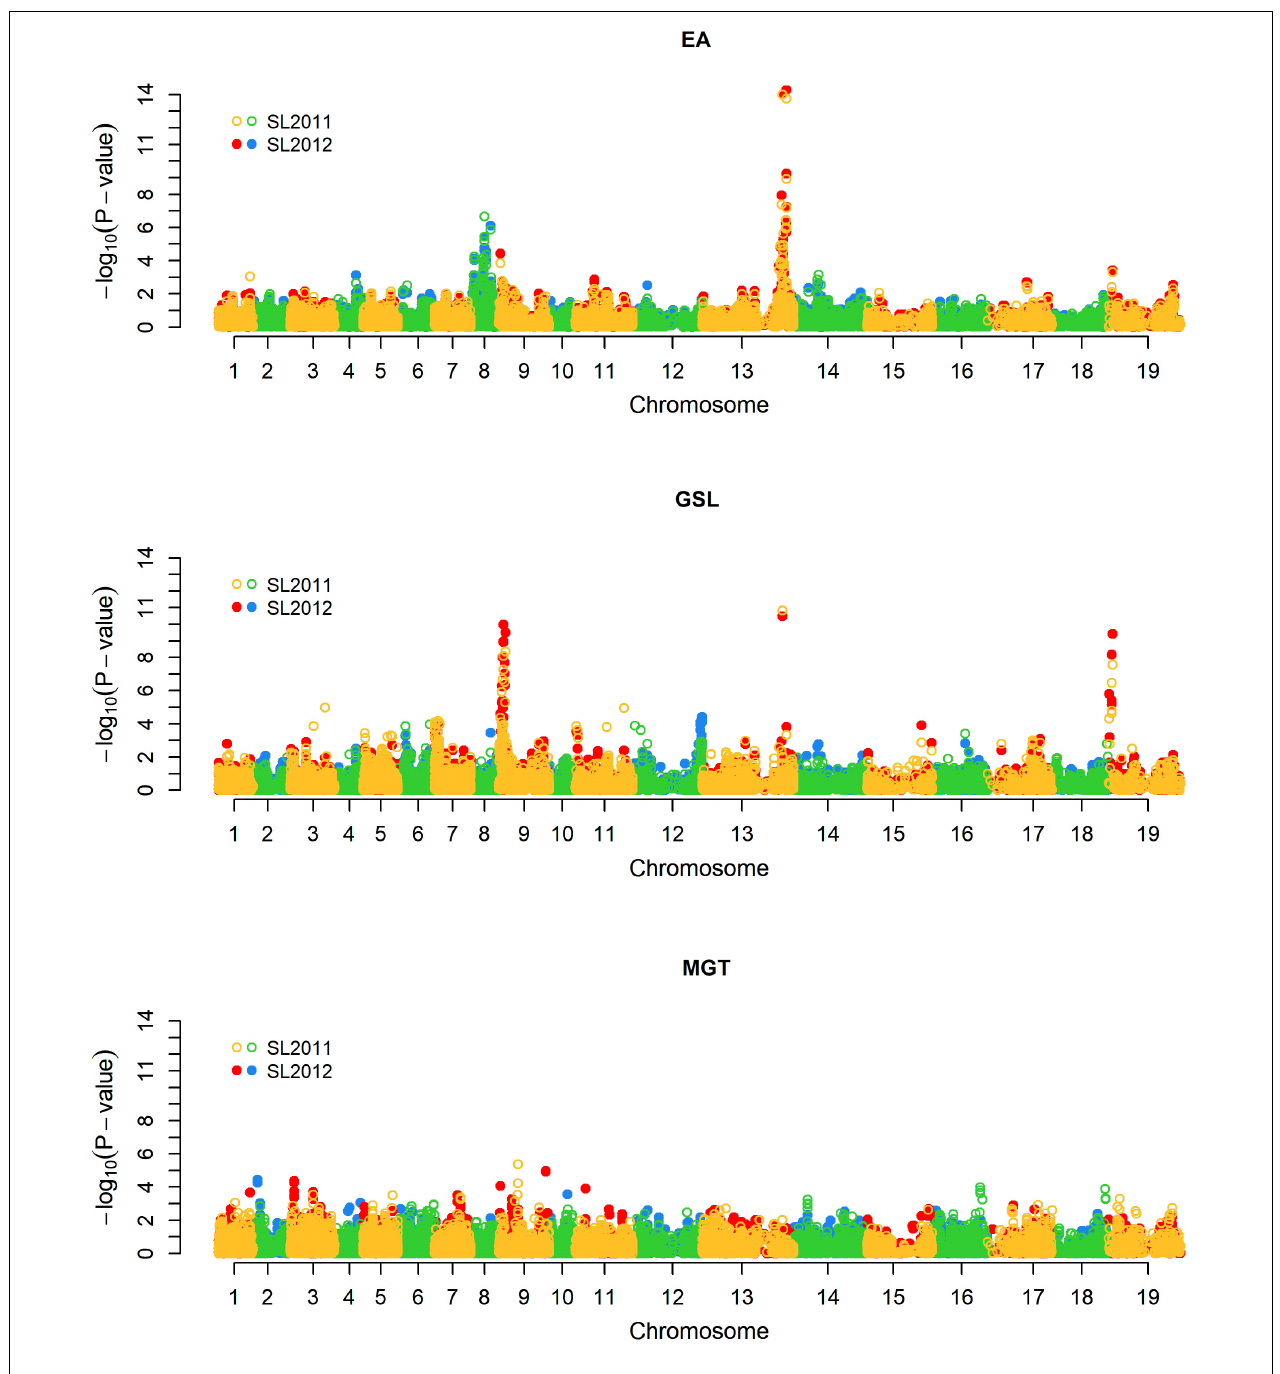
FIGURE 5 | Manhattan plot describing genome-wide marker-trait associations for the traits seed erucic acid content, seed glucosinolate content, and mean germination time. Yellow and green dots represent associations calculated for seed lot SL2011. Red and blue dots represent associations calculated for seed lot SL2012. EA: Seed erucic acid content, GSL: Seed glucosinolate content, MGT: Mean germination time.